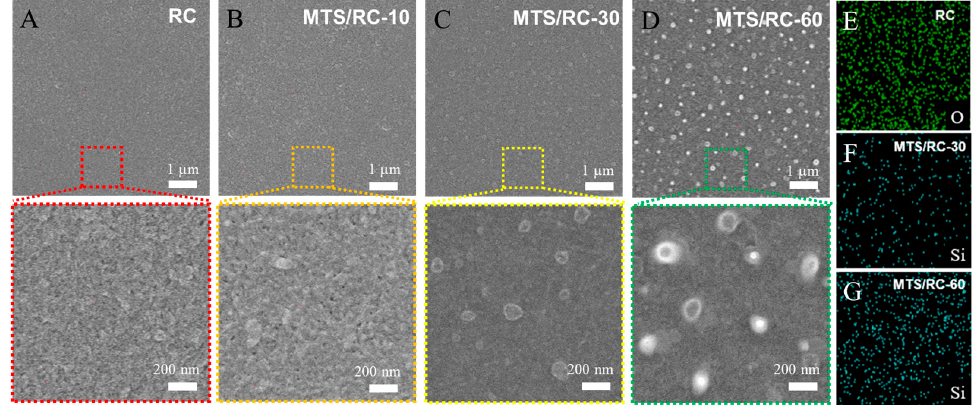
Figure 2. Top-view FE-SEM images of ( A ) the pristine RC film and ( B – D ) the MTS/RC-10, -30, and -60 films as a function of the MTS deposition time (10, 30, and 60 min). EDS elemental mapping images of ( E ) the pristine RC film, ( F ) MTS/RC-30, and ( G ) MTS/RC-60.